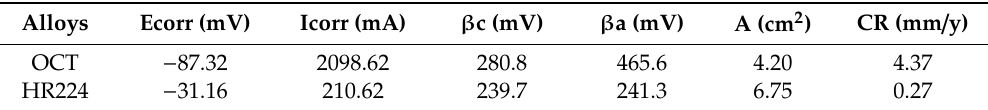
Table 4. Electrochemical parameters and corrosion rates obtained and linear polarization resistance (LPR) test for OCT and HR224